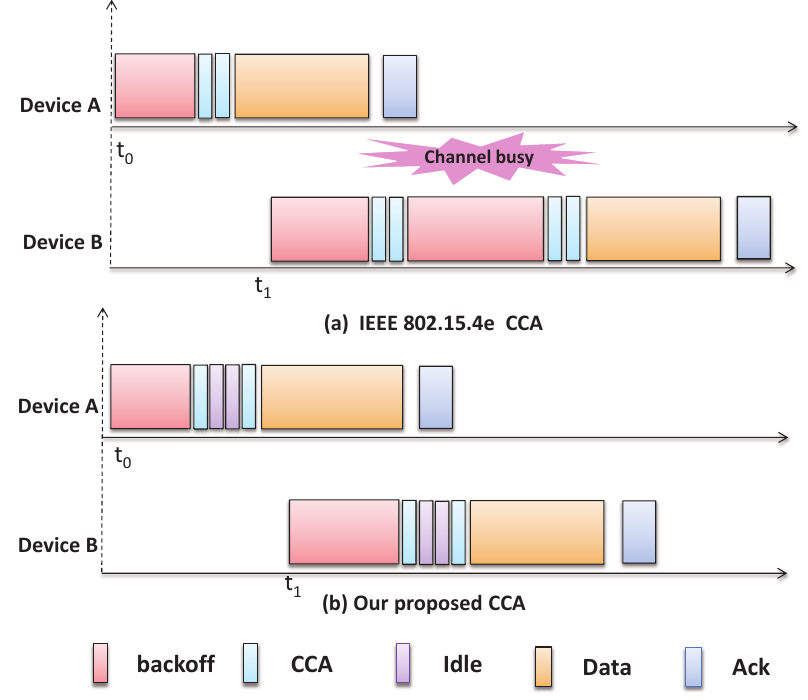
Figure 3. A new CCA scheme for IEEE802.15.4e to avoid channel busy due to